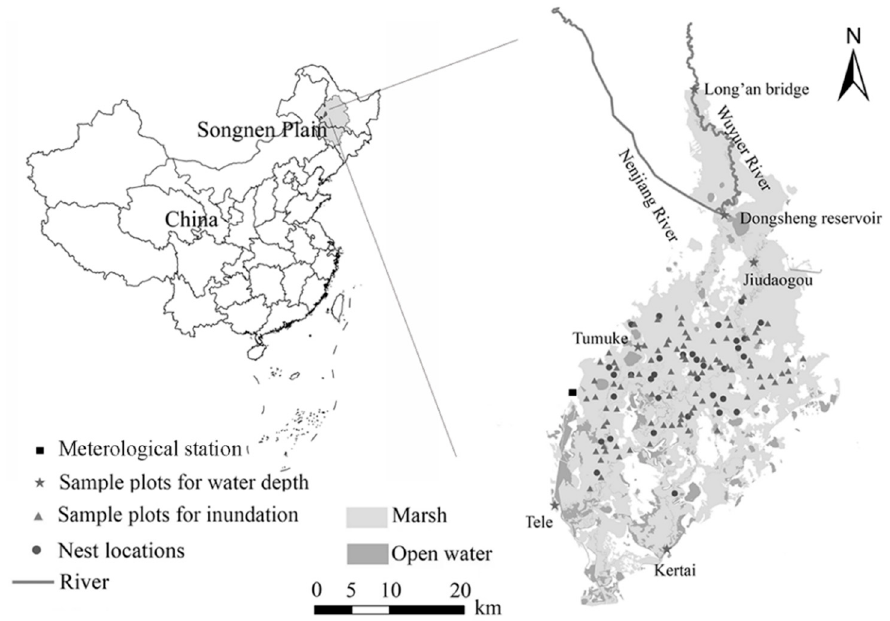
Figure 1. Location of the Songnen Plain in Northeast China ( left ) and the study area ( right ).